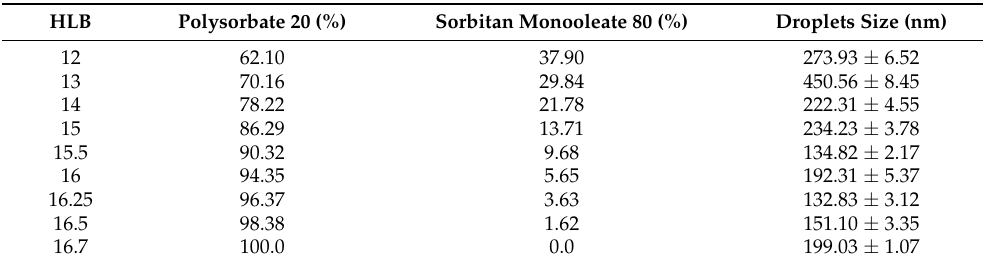
Table 2. HLB range values, the proportion of surfactants, and mean size of emulsions with 5% ( w / w ) of E. sulcata essential oil.